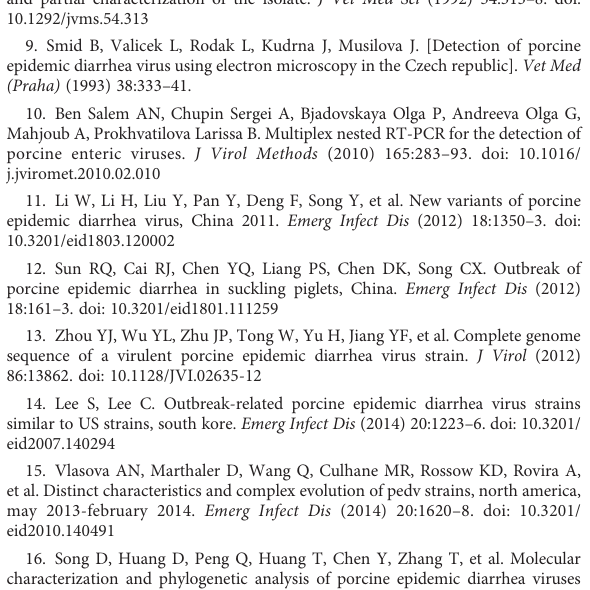
SUPPLEMENTARY FIGURE 4 The attenuated strain FJzz1-F200 infection induced the production of type I and type III IFNs. (A – D) Transcriptional levels of IFN- b , IFN- l 1, IFN- l 3, and IFN- l 4 in PEDV-infected cells. LLC-PK1 cells were infected with FJzz1-F200 at an MOI of 0.01, and total cellular RNA was prepared at 18 hpi to determine the mRNA level of IFN- b (A) , IFN- l 1 (B) , IFN- l 3 (C) and IFN- l 4 (D) by RT-qPCR. These data are representative of the results of three independent experiments and error bars represent standard deviations. Asterisks indicate statistical signi fi cance. ***, P < 0.001. SUPPLEMENTARY TABLE 1 Nucleotide and amino acid homology analysis of the FJzz1